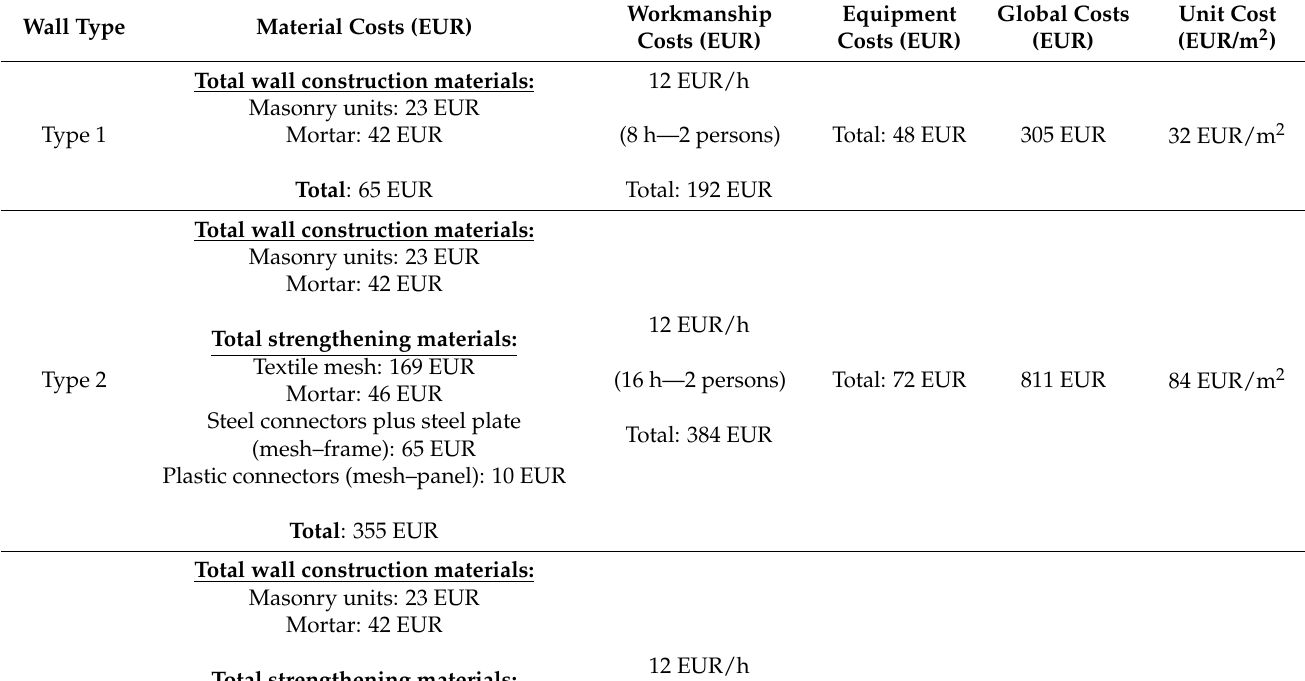
Table 5. Summary of the costs of each wall